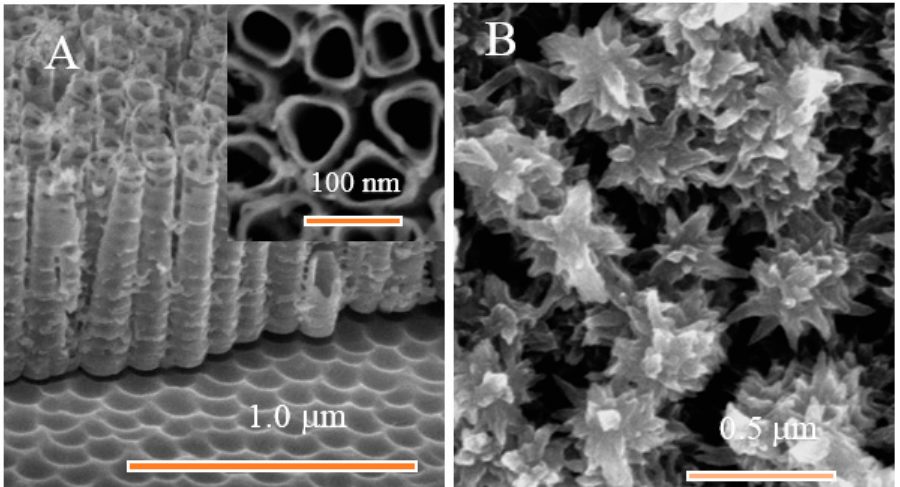
Figure 3. Panoramic ( A ) and top-side [inset in ( A )] SEM image of TiO 2 film before and after polyaniline chemical deposition ( B ) from an aqueous solution of 1 mol L − 1 HCl containing 0.9 mL L − 1 aniline and 90 mL L − 1 K 2 S 2 O 8 solution (2.5 wt.%) at ice temperature for 12 h.